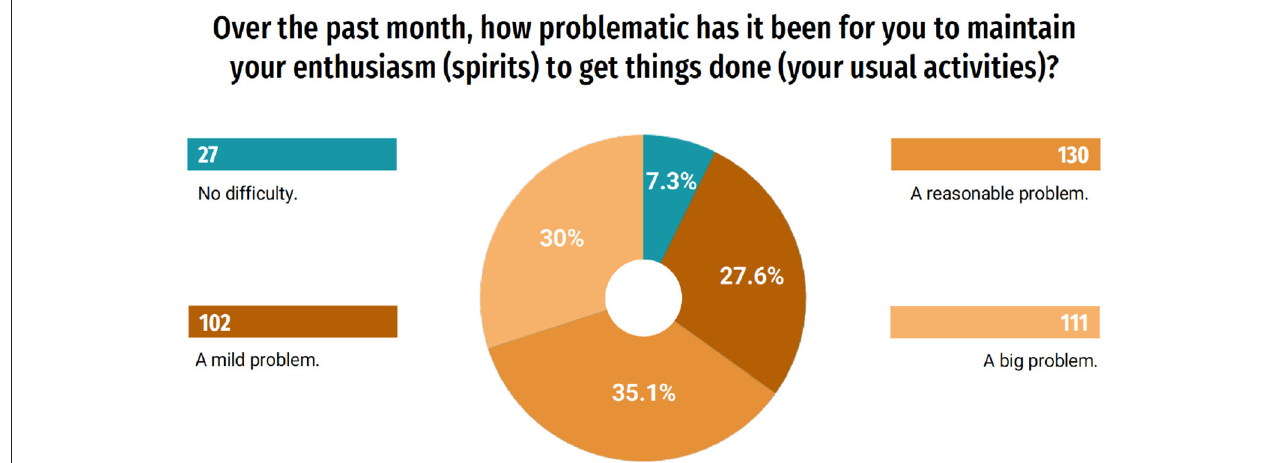
FIGURE 3 | Maintenance of enthusiasm for usual activities.